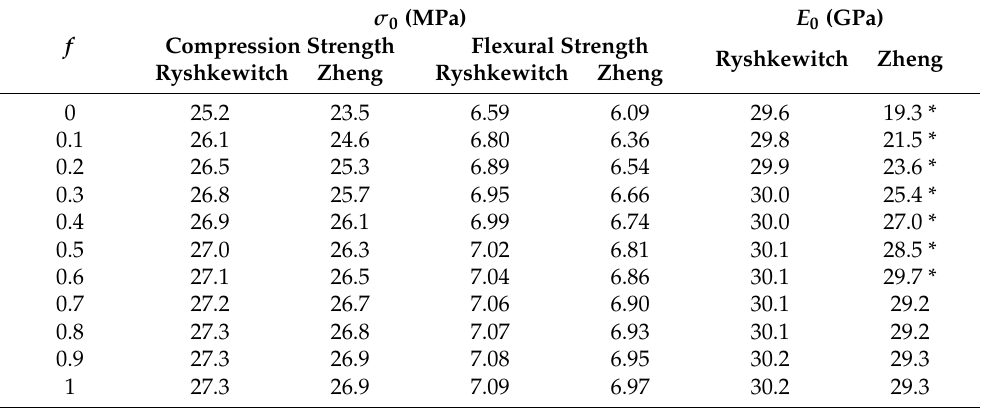
Table 2. Values of σ 0 and E 0 parameters for the Ryshkewitch and Zheng models, as a function of the fraction, f , of the plastic aggregate considered as porosity in the model. σ 0 (MPa) E 0 (GPa) Compression Strength